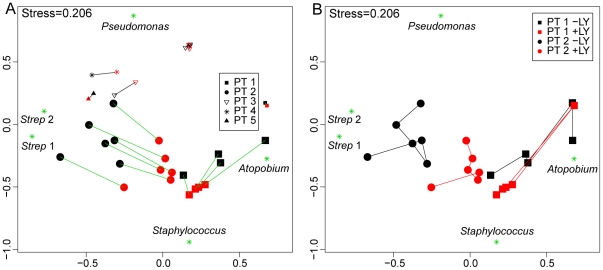
Impact of DNA extraction method on community structure and dynamics.(A) Biplot showing the pairwise comparison of community structures for the 10 Staphylococcus-rich (large symbols) and the 7 Staphylococcus-poor (small symbols) sputum samples using nonmetric multi-dimensional scaling (nMDS). Pairs from the same sample processed with standard lysis method (black symbols) or lysostaphin-lysozyme method (red symbols) are connected by a line and are more similar to each other the closer they are on the ordination plot. The top 5 OTUs (labeled as green stars) most responsible for shifting samples on the ordination plot were: Staphylococcus, Pseudomonas, Strep 1 (Streptococcus pneumoniae), Strep 2 (Streptococcus milleri group) and Atopobium. (B) Comparison of community structure dynamics in serial sputum samples collected from Patient 1 (square, n = 5) and Patient 2 (circles, n = 6). The ordination plot is the same as that in (A) except that samples prepared by the standard lysis method (black) or lysostaphin-lysozyme method (red) are connected by lines chronologically.